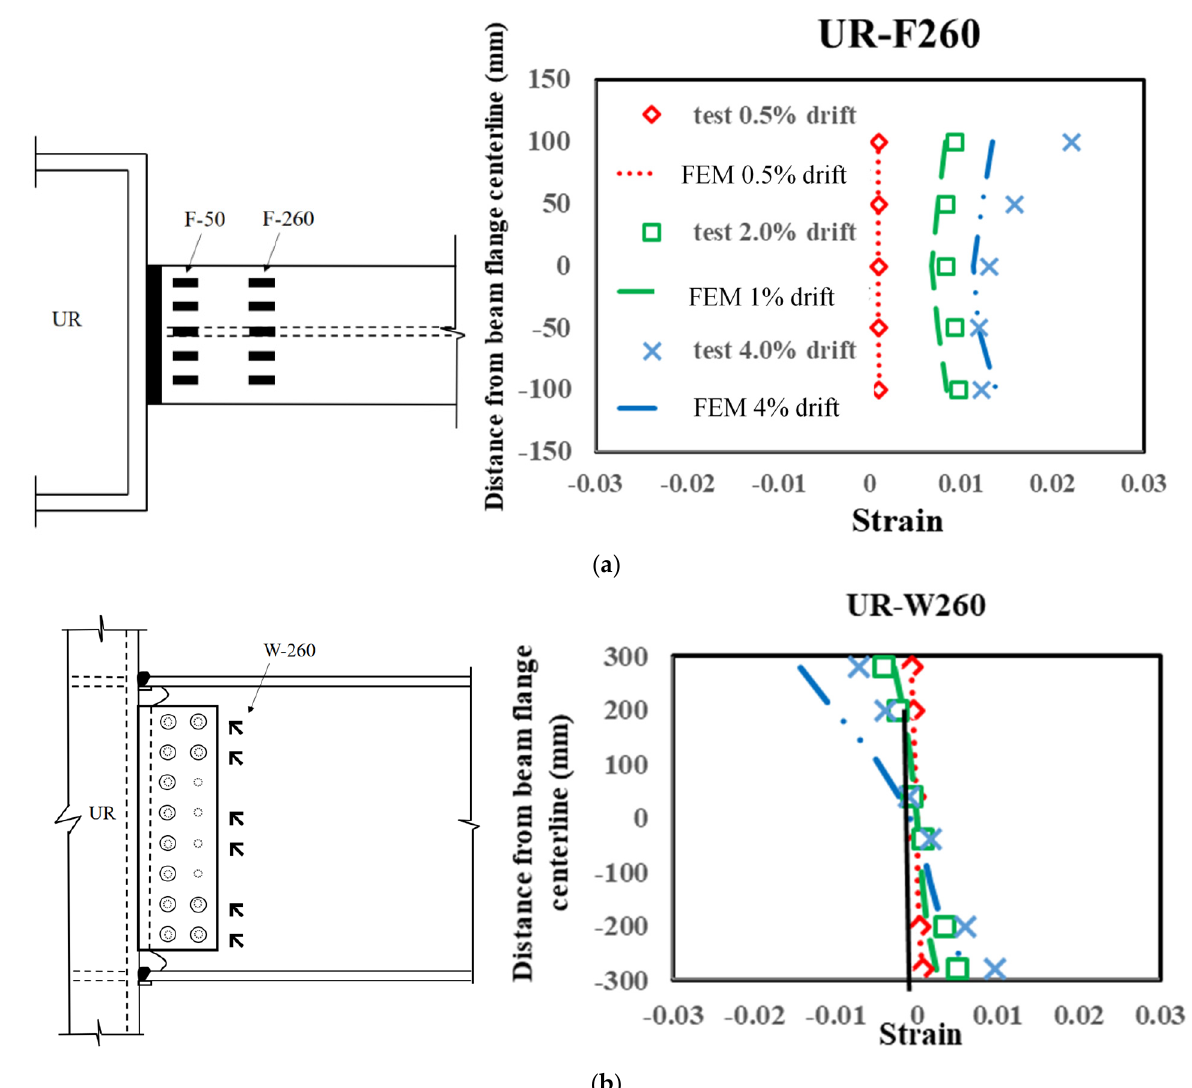
Figure 5. FEM simulation of strain measurement: ( a ) flexural strain, ( b ) shear strain.